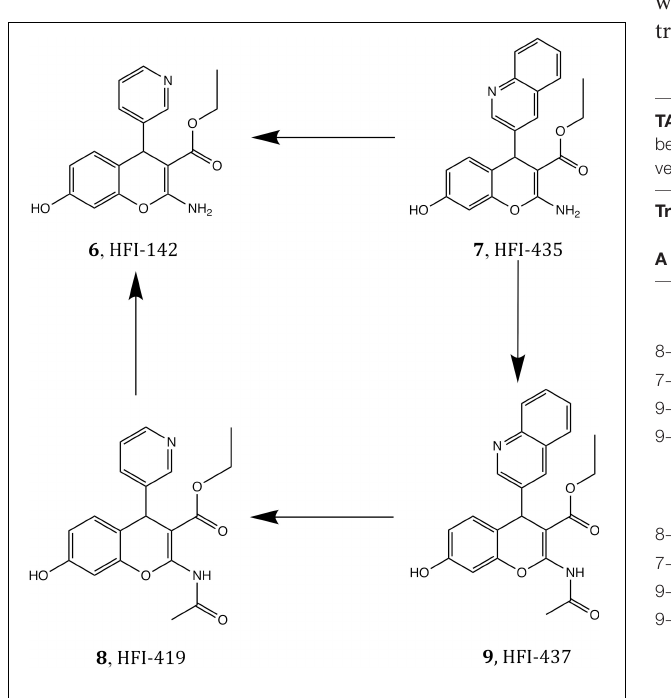
closed thermodynamic cycle shown in Figure 5 explore the effect of replacing the acetamide by a free amino group in position 2 of the benzopyran ring, while the horizontal legs refer to the change of replacing 3-quinoline by 3-pyridyl.